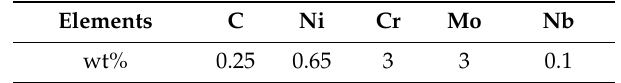
Table 1. Chemical composition of 25Cr3Mo3NiNb for phase diagram calculation.